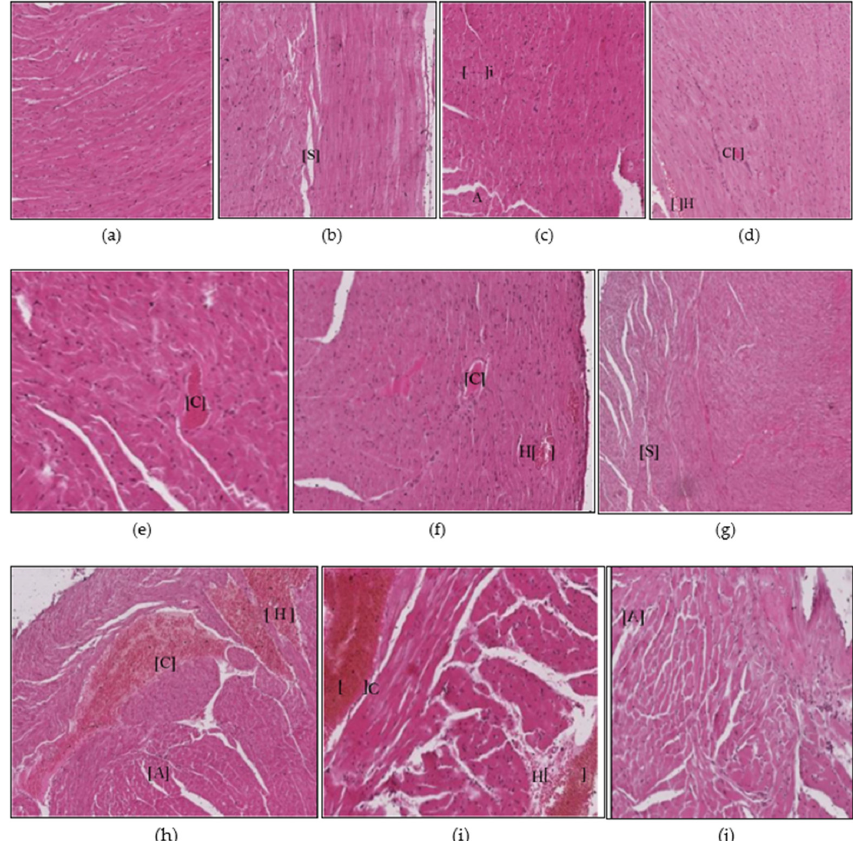
Figure 4. Histopathological photomicrographs (H&E, 400 × ) of heart tissues showing microscopically observed control ( a ), and the changes after exposure to mosquito repellant ( b – d , Mat-based vapor,